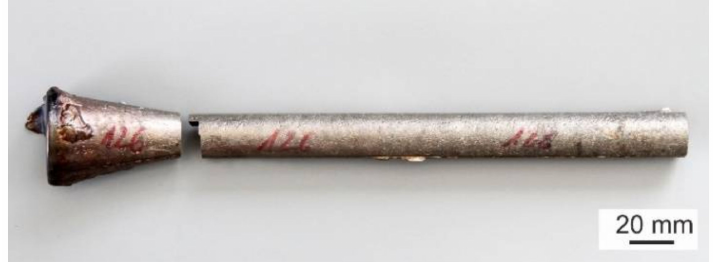
Figure 3. The typical example of the as-cast ingot from Ti-45Al-2W-xC